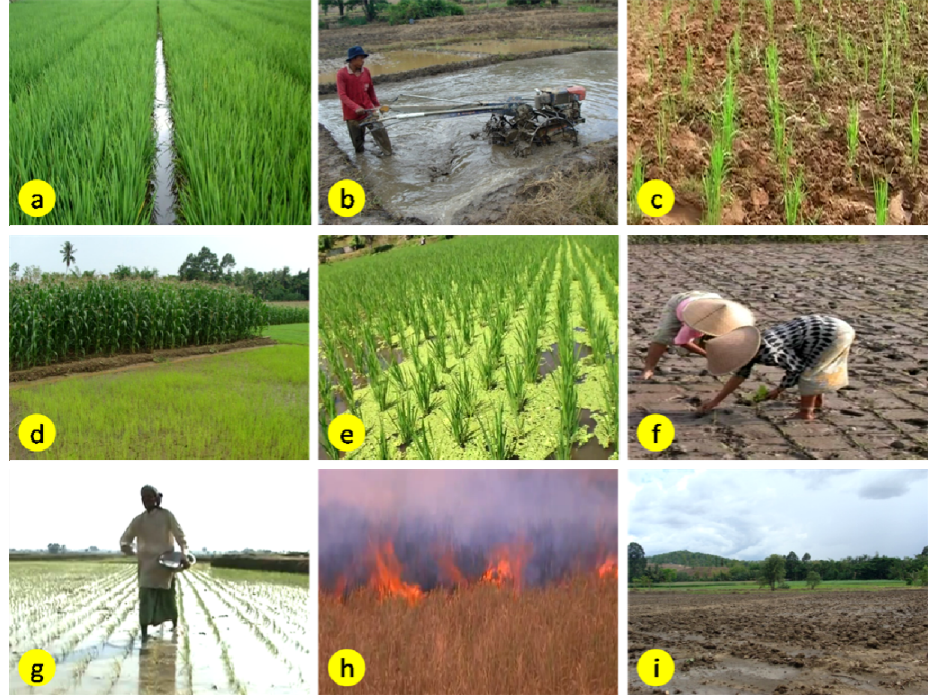
Figure 1. Field management practices that influence TE availability in rice fields ( a ); Irrigation ( b ); Puddling ( c ); Dry land cultivation ( d );Mixed or co-cropping ( e ); Azolla cultivation ( f ); System of rice intensification ( g ); Fertilizer application ( h ); Burning of crop residues ( i ); Rice cultivation near mine